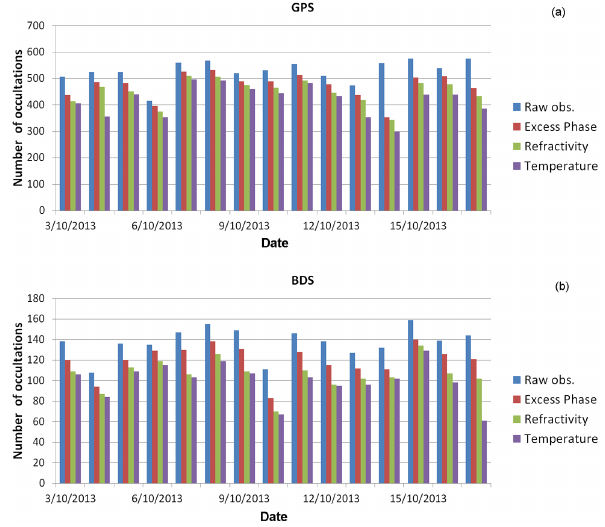
Figure 1. Daily number of occultations for (a) GNOS GPS and (b) GNOS BDS from raw observations to temperature. This is the status of 15 days starting 3 October 2013. Different colours indicate different stages after the corresponding quality